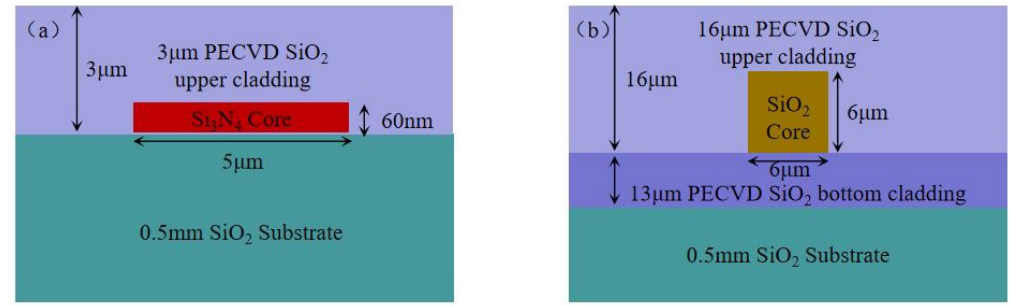
Figure 5. Cross sections of the ( a ) silicon nitride waveguide and the ( b ) silicon dioxide waveguide.